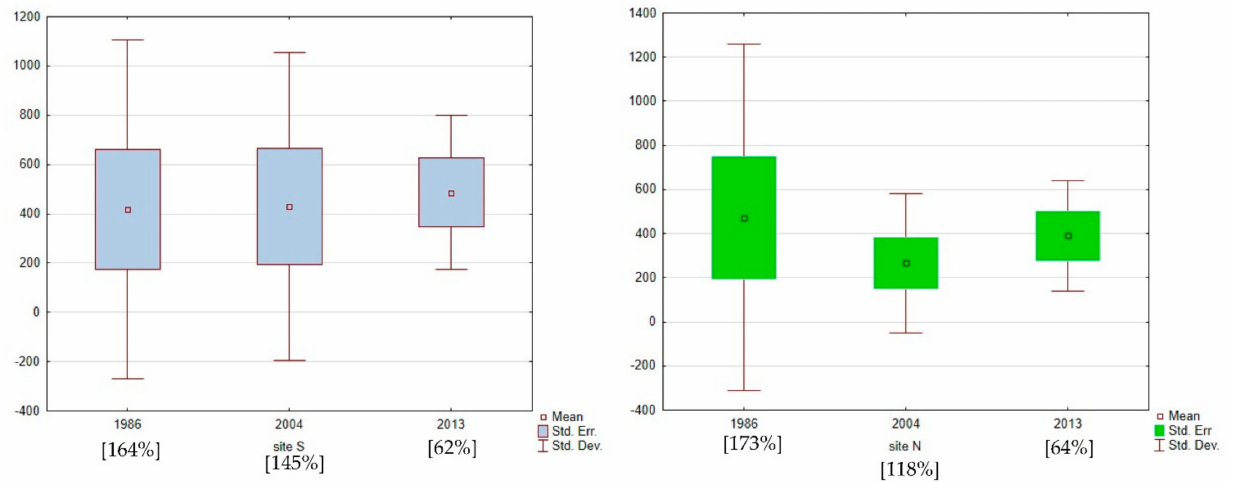
Figure 2. Temporal variability (mean values, standard error, standard deviation) of rotifer abundance [indiv. L − 1 ] at the sites in Lake Kortowskie; all differences were insignificant ( p > 0.05). S–the site in the southern basin of the lake, where the pipeline is located; N–the site in the northern basin of the lake; [variability indices in parentheses].